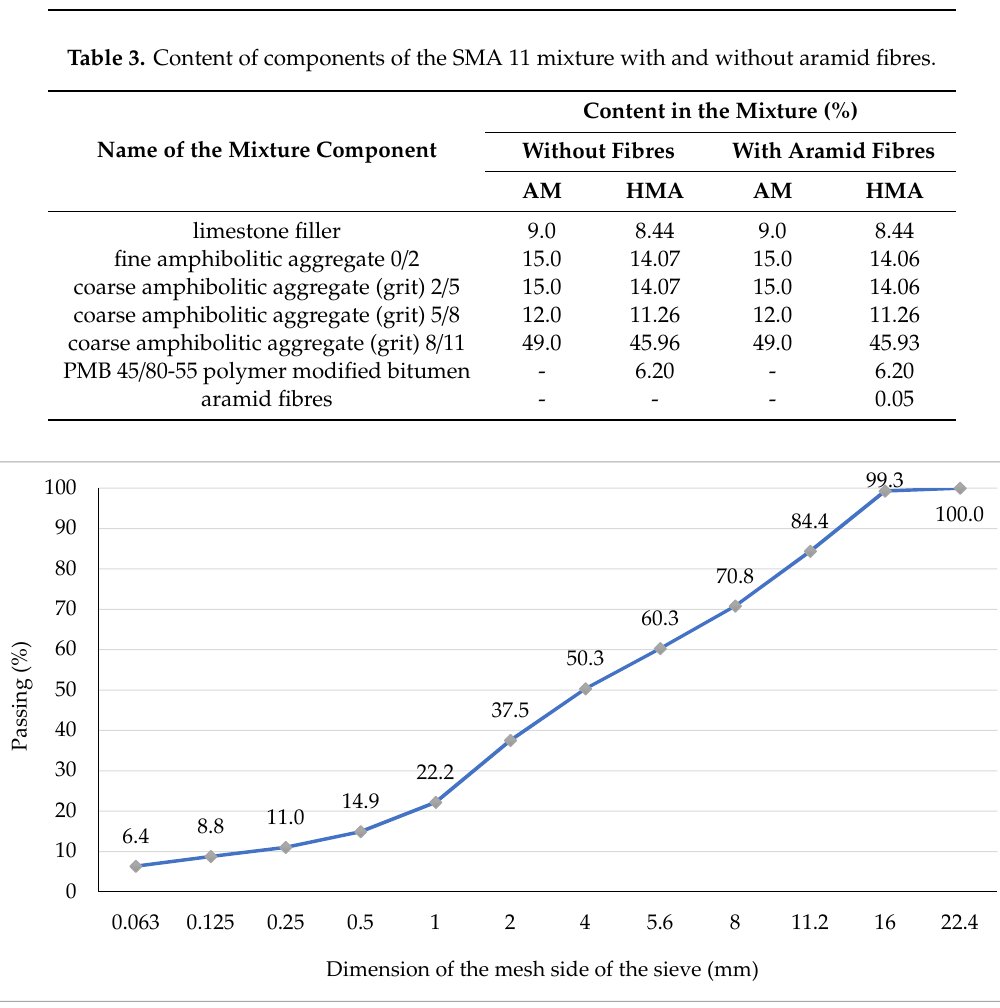
Figure 2. Graph of grain size distribution curve of the HMAC 16B mixture.